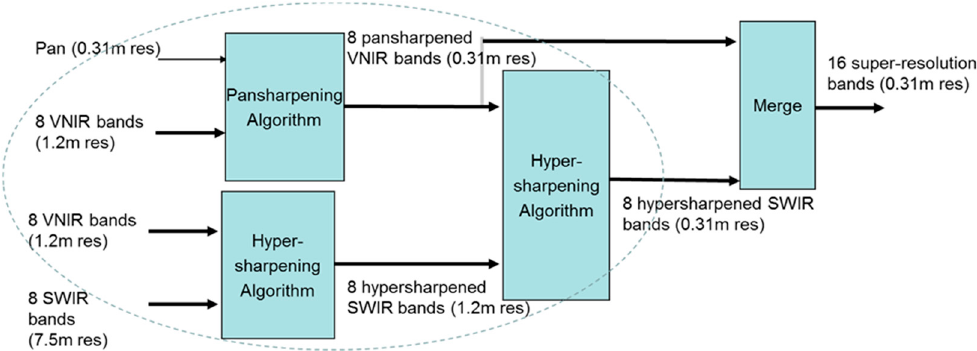
Figure 13. Approach 3: Sequential-parallel fusion of pan, VNIR, and SWIR bands.